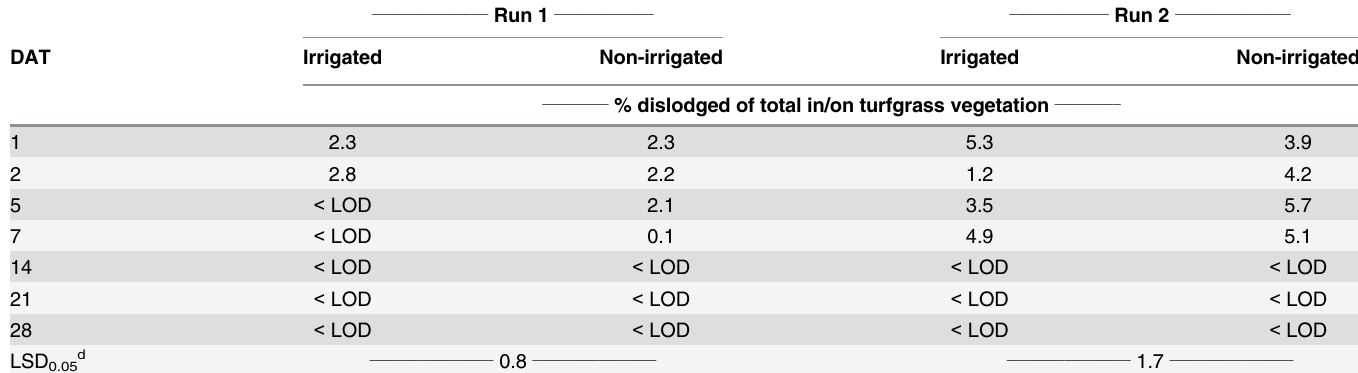
a Abbreviations: DAT, d after treatment (2,4-D); LOD, limit of detection; NS, not signi fi cant. b